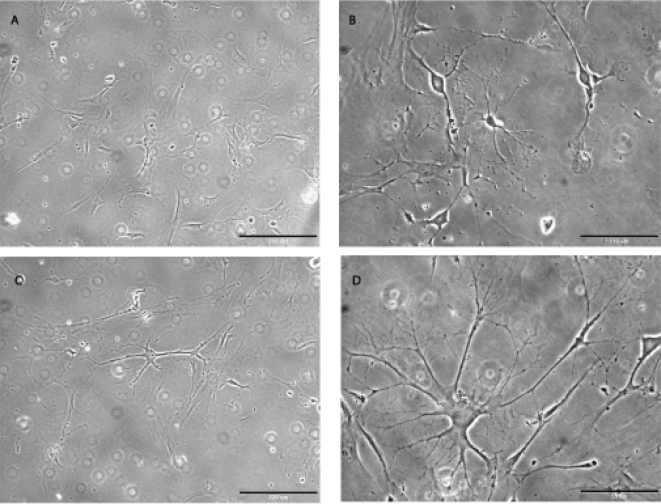
Proliferation and differentiation of mouse ADAS cells in cell culture medium designed for mesenchymal stem cells.Phase-contrast image of undifferentiated mouse ADAS cells at passage 5 (A) and passage 22 (C); process outgrowth in the same cells after 4-hr exposure to Neural Induction Medium (NIM)(B and D, respectively). Scale bar in A and C = 220 um; scale bar in B = 110 um; scale bar in D = 55 um.